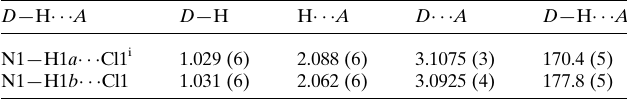
Table 1 Hydrogen-bond geometry (A˚ , (cid:4) ).